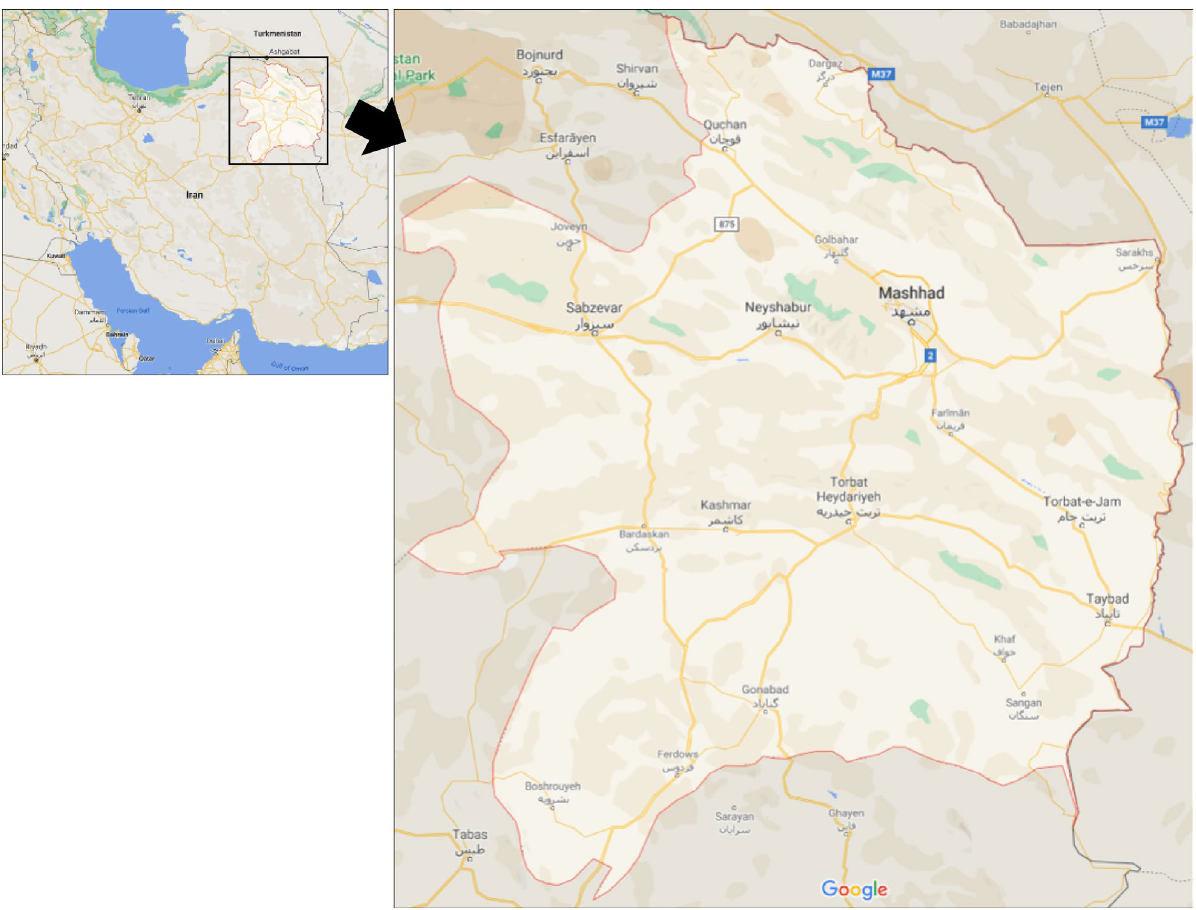
Figure 1. Khorasan Razavi Province and its rural roads map [Maps Data: ©2021 Google].